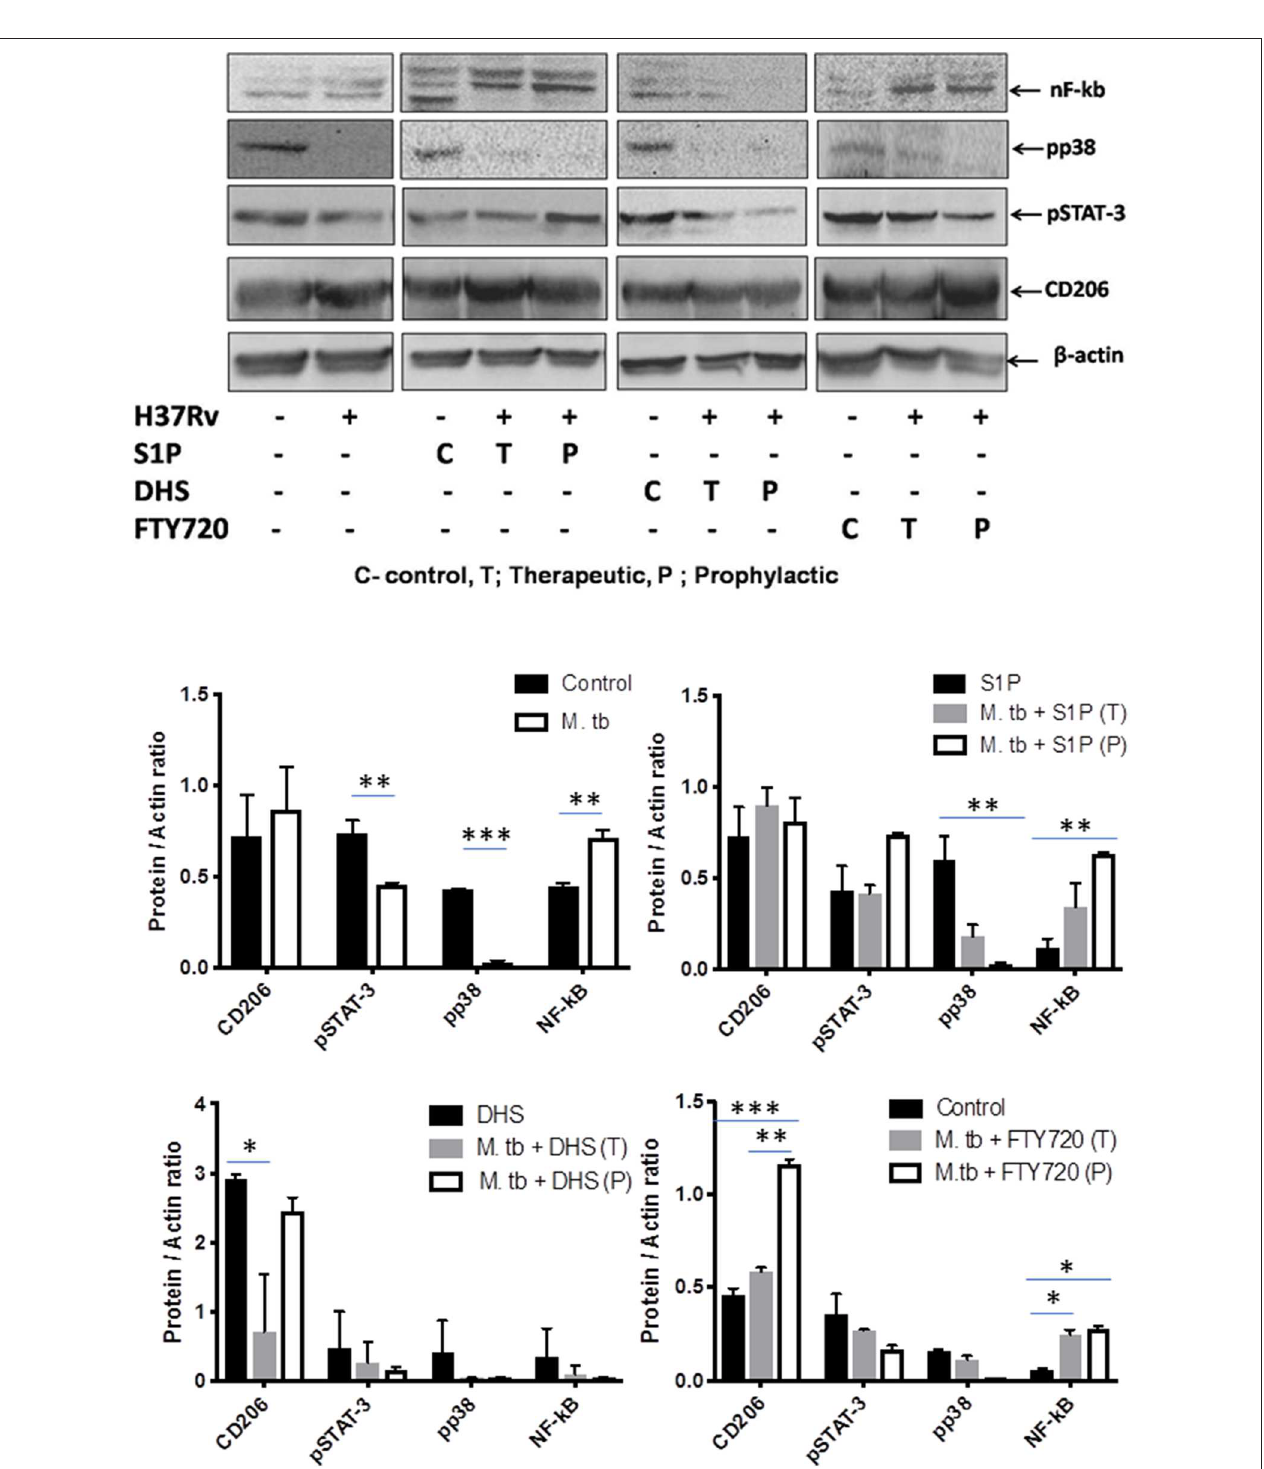
FIGURE 10 | Sphingosine-1-phosphate (S-1P) promotes innate immune signaling during M. tuberculosis challenge. Whole lung lysates of infected mice treated with indicated sphingolipid drug derivatives were purified and analyzed for the expression of various key signaling proteins vis NF- κ b, pp38, pSTAT-3, and CD206 by Western blot analysis. Shown are the representative Western blots obtained from each group. β -actin was used as a loading control. Densitometric quantification of the representative Western blots obtained from each group was analyzed by ImageJ, and the values were plotted in terms of relative protein expression. Statistical analyses were conducted using two-way ANOVA followed by Bonferroni posttest (* P < 0.05, ** P < 0.01, *** P < 0.001).